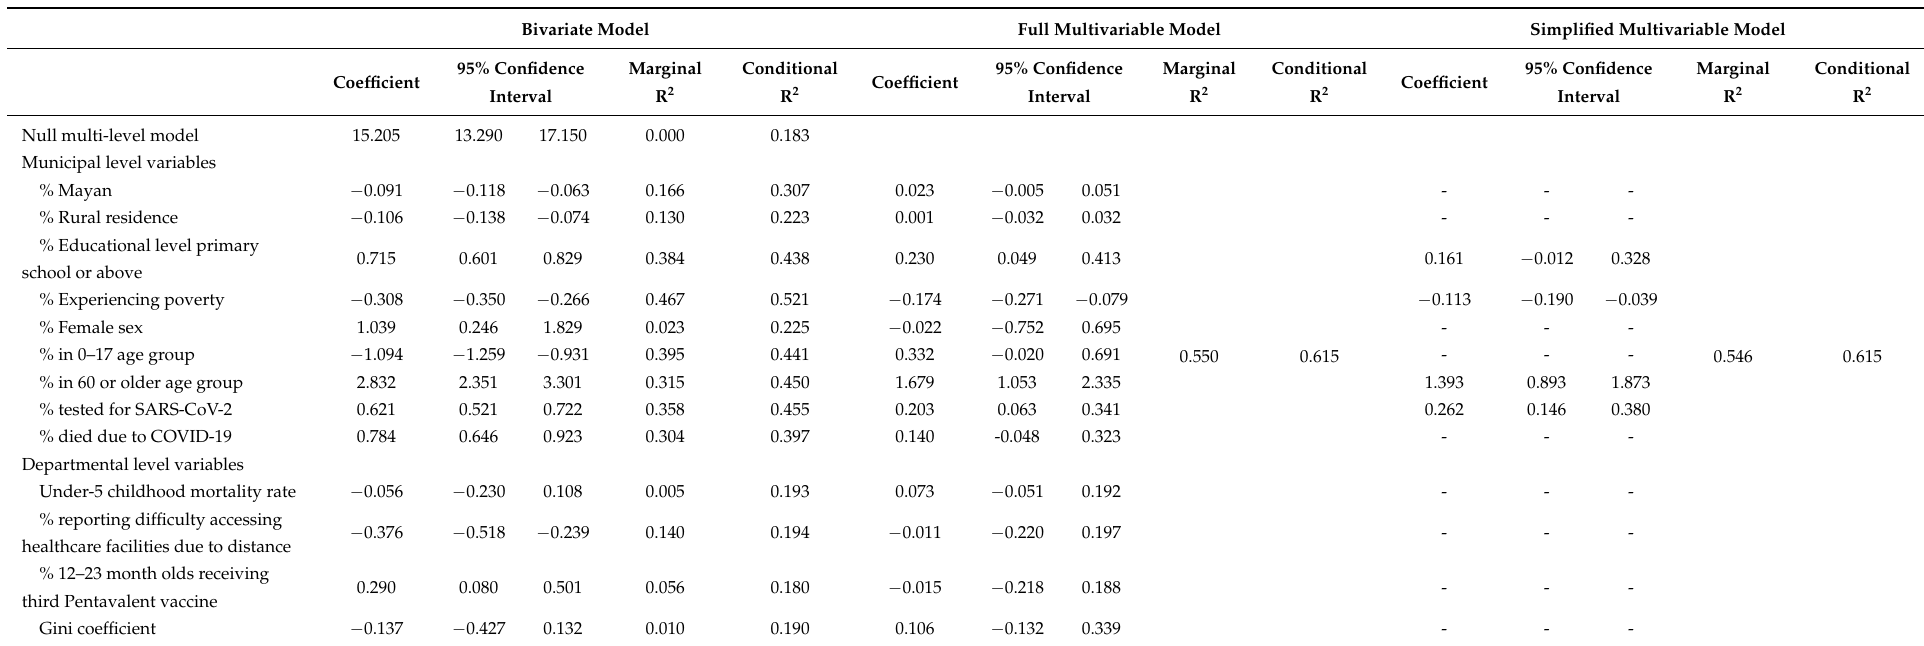
Table 5. Association between sociodemographic factors (by municipalities and departments) and two-dose vaccination coverage (%) by municipalities in Guatemala (N = 336). SARS-CoV-2 case and vaccination data are from 13 February 2020 to 1 October